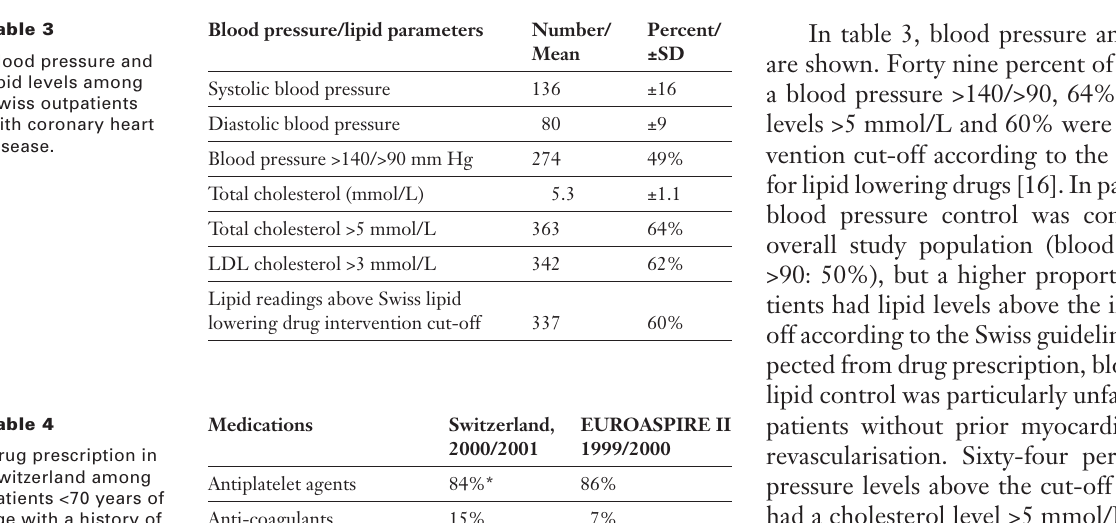
Drug prescription in Switzerland among patients <70 years of age with a history of myocardial infarction or coronary revascu- larisation (n = 260) as compared to the therapy in other European countries (EUROASPIRE